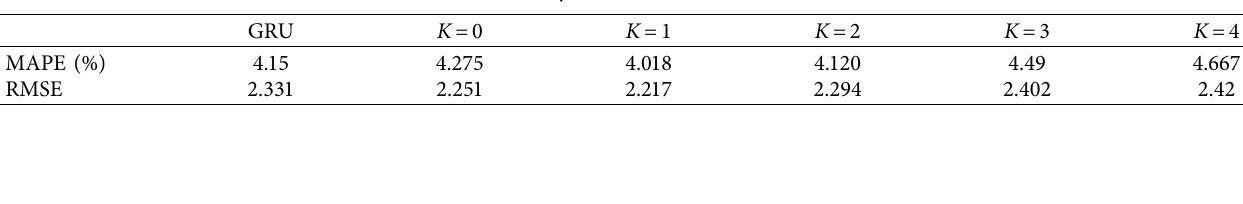
Table 4: Prediction accuracy of road Section 2 for different K